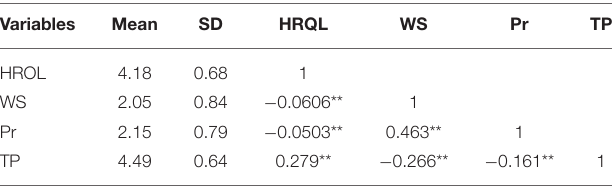
TABLE 1 | Demographic characteristics and task performance of 4,261 participants.